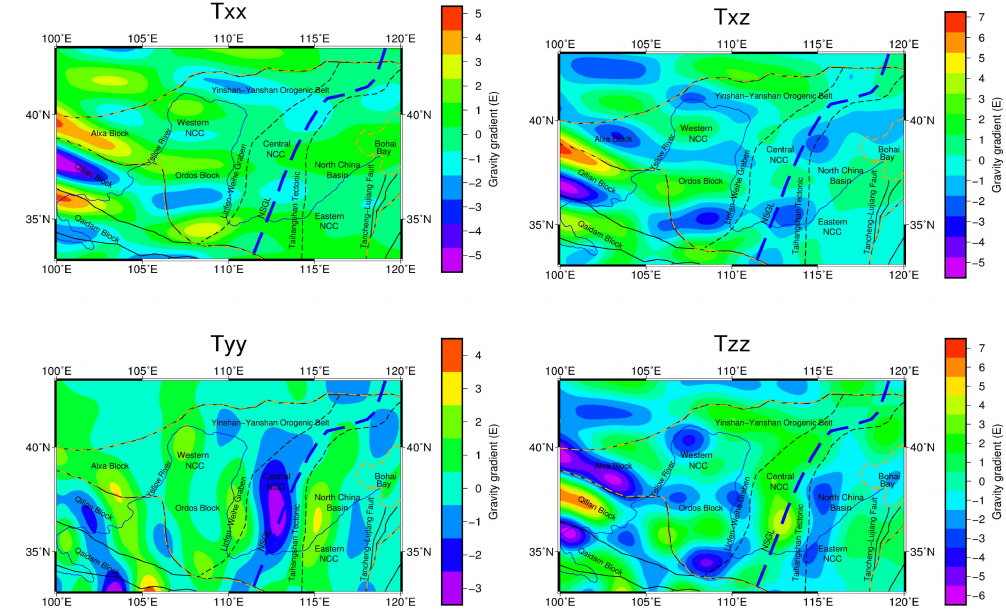
Figure 8. Gravity gradient effect ( T xx , T xz , T yy , T zz ) after downward continuation to an altitude of 10km.